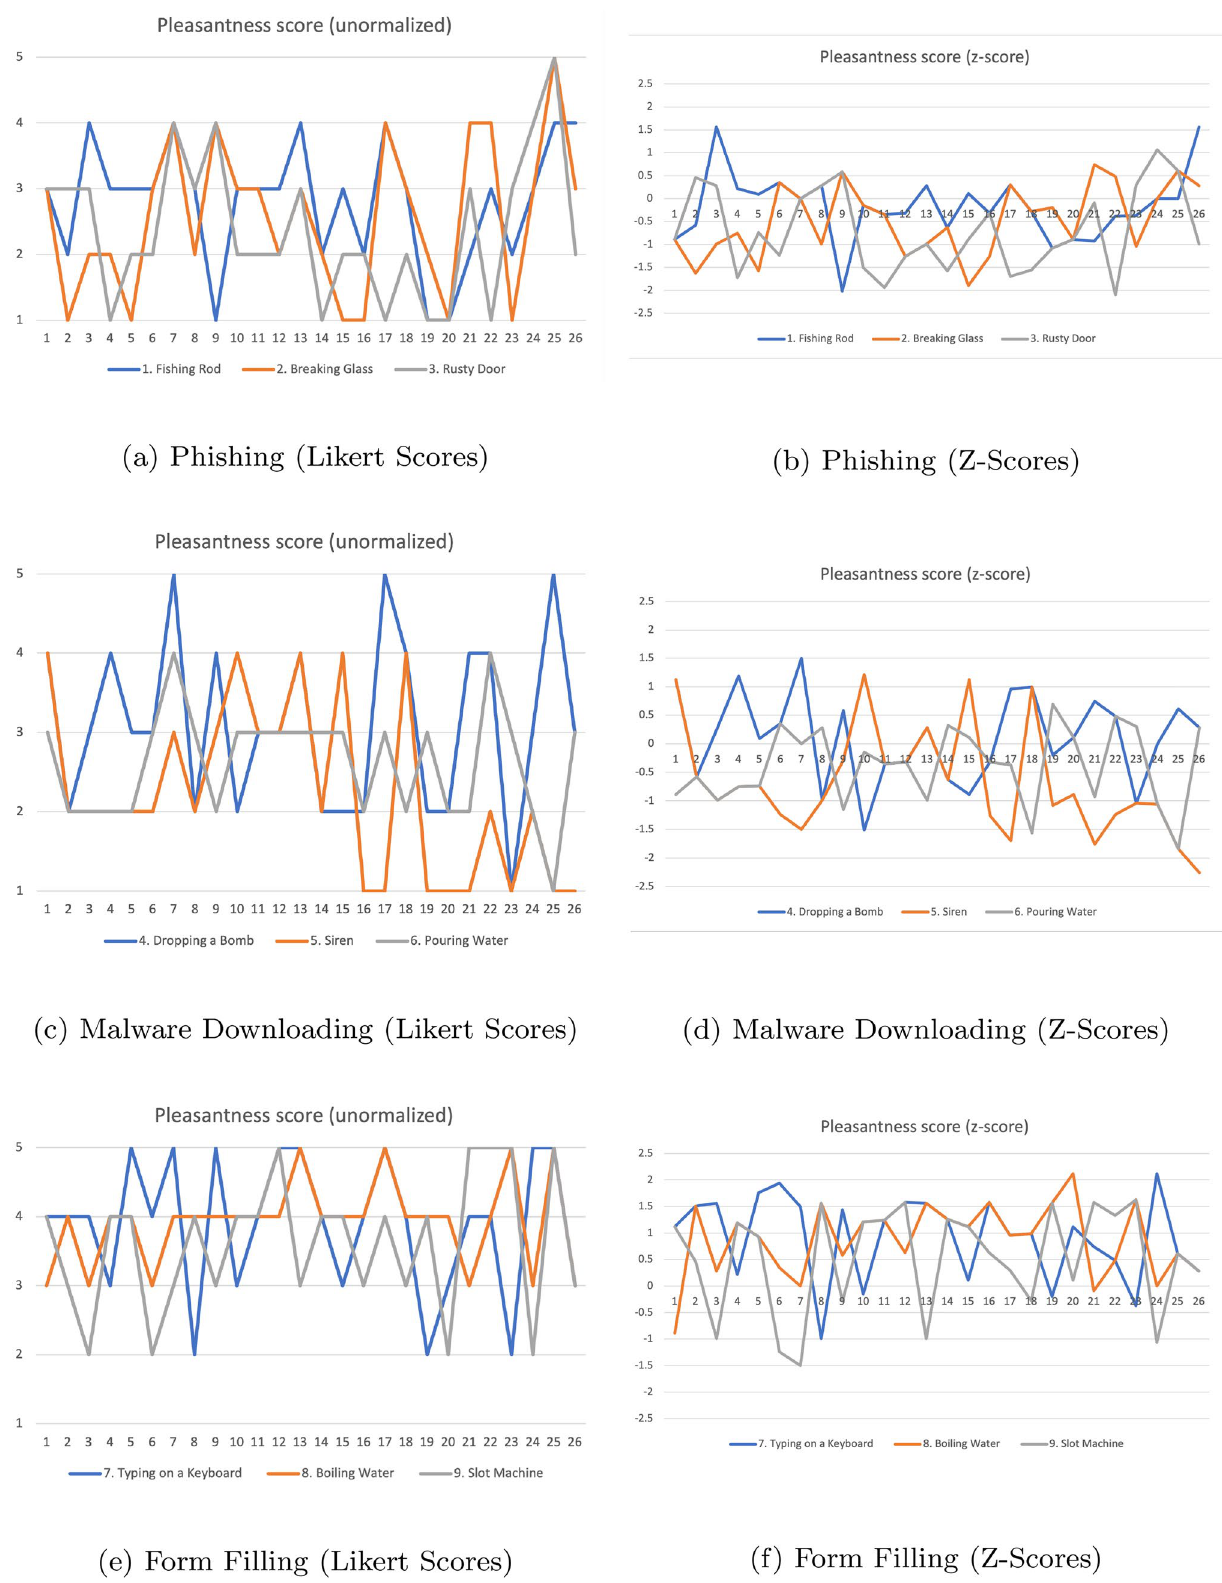
Fig. 5 The Unnormalized and Normalized scores for Pleasantness